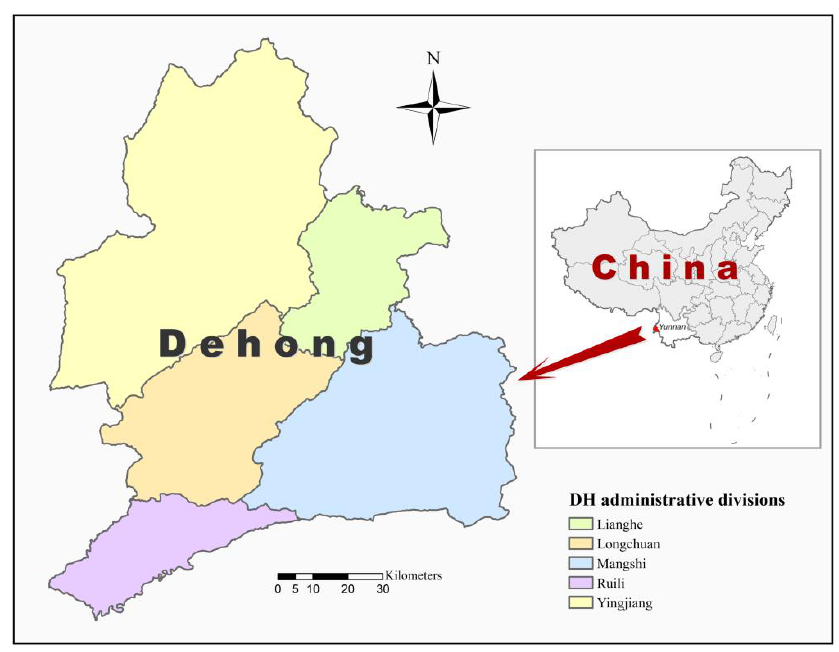
Figure 1. Administrative divisions and geographical position of the Dehong (DH) Prefecture.